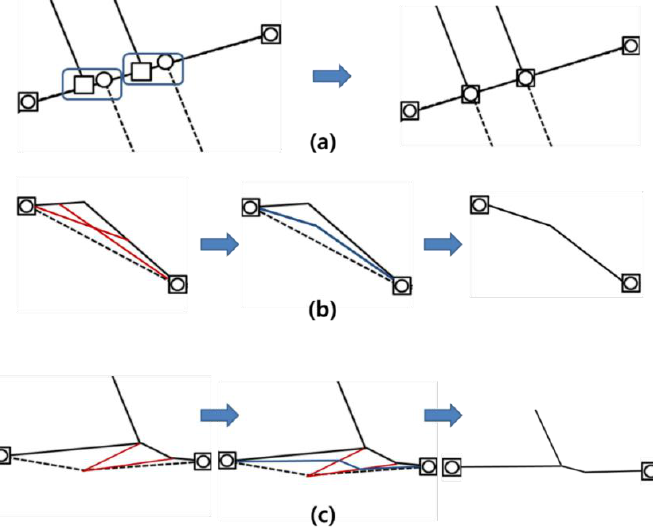
Figure 7. Map alignment method for geometric difference case in this study; ( a ) linear difference, ( b ) triangle difference and ( c ) polygon